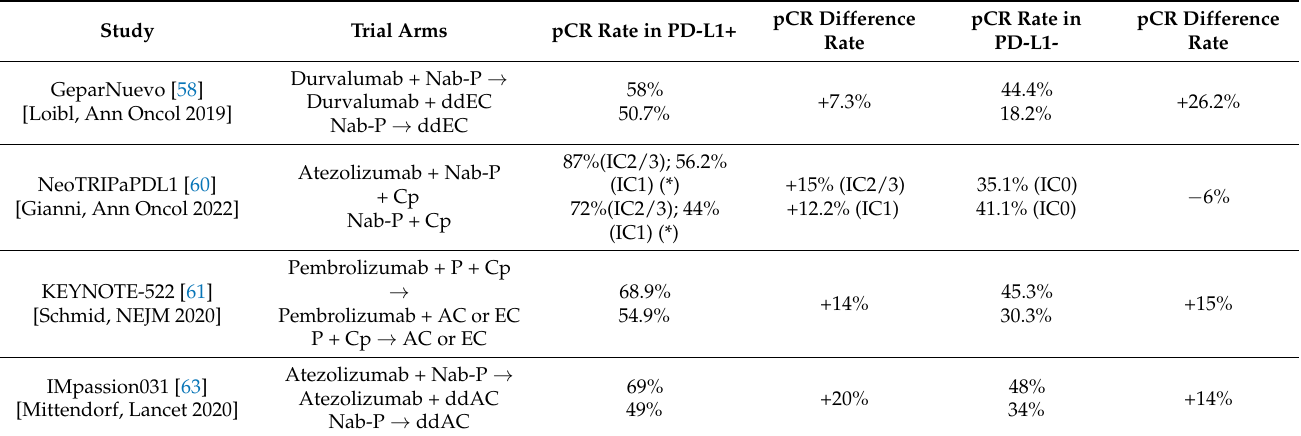
Table 2. Pathological complete response rate based on the PD-L1 status (positive vs. negative) in neoadjuvant immunotherapy randomized